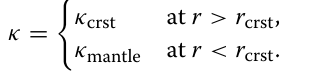
∗ Table 2). q tr changes with time as: